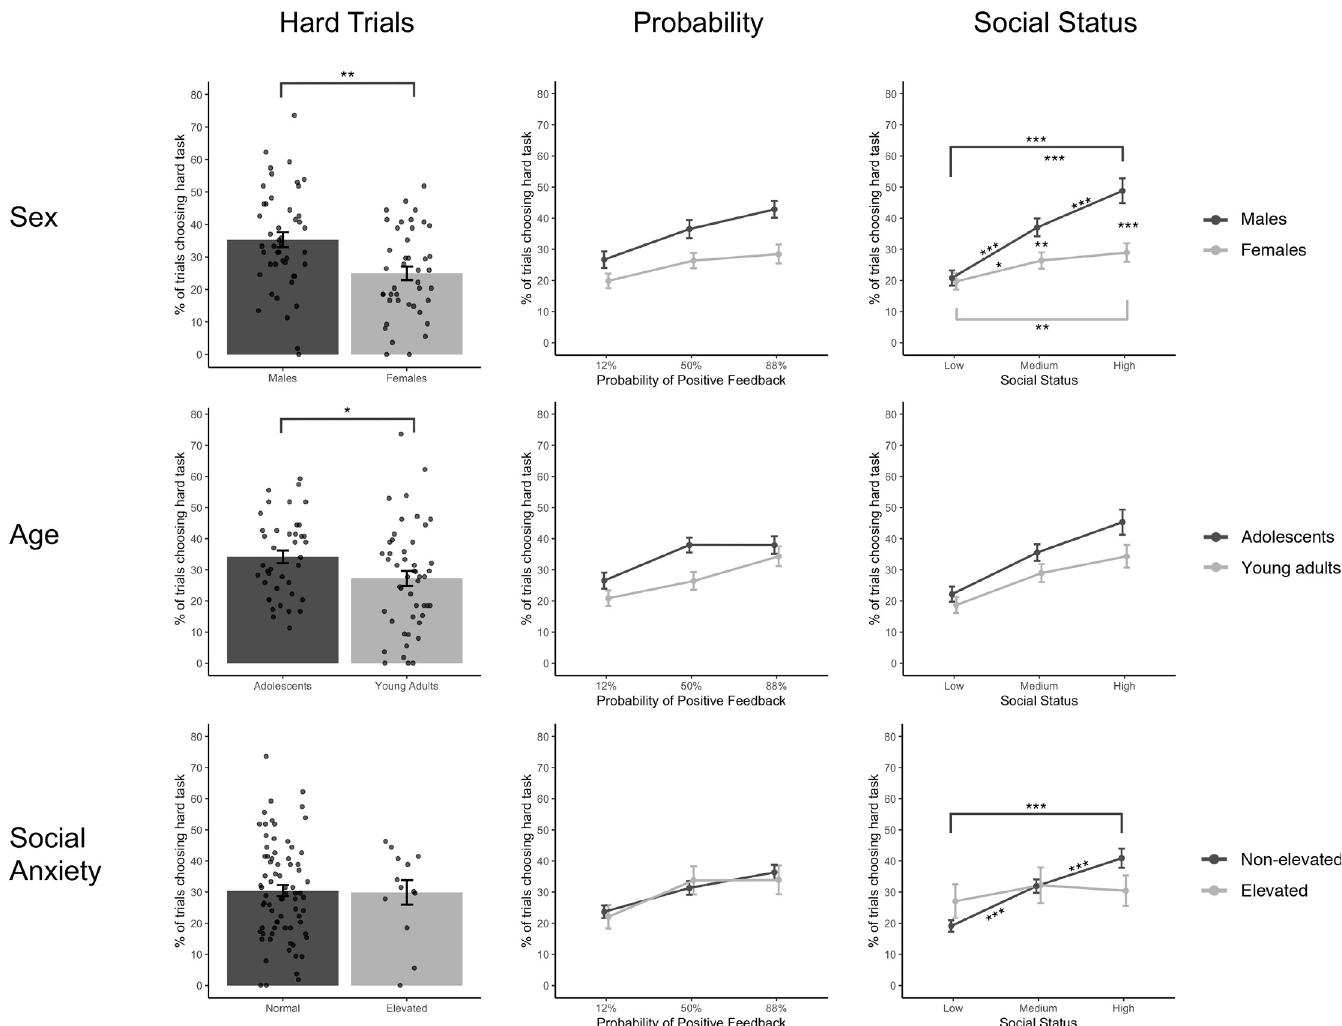
Fig 3. Hard task choices by sex, age, and social anxiety. Hard task choices (mean ± SEM) by sex, age, and social anxiety levels across all trials, by probability conditions, and by social status conditions. Significant main effects and interactions noted along with all statistics in S1, S2, S4 and S5 Tables. Asterisks denote significance at � p < .05, �� p < .01 and ��� p <